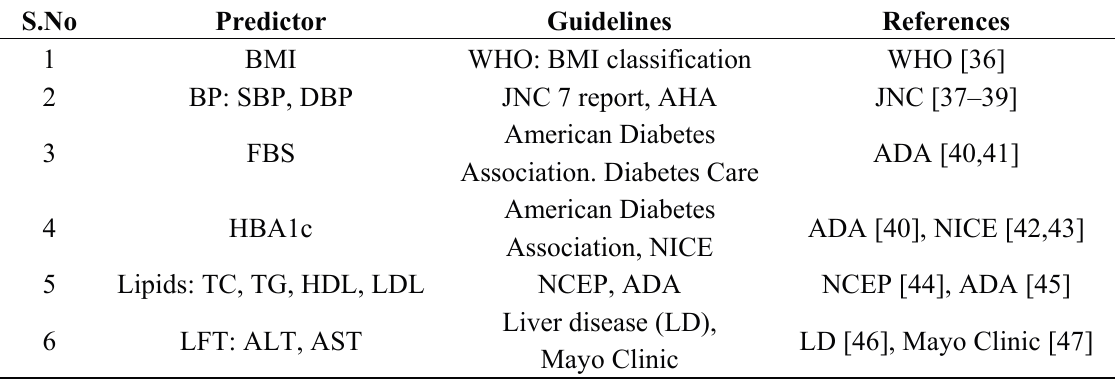
Figure 2. An encounter of type-2 diabetes mellitus patient (T2DM), following subjective, objective, assessment, and plan (SOAP)-based protocol. Table 1. List of guidelines used for managing diabetes